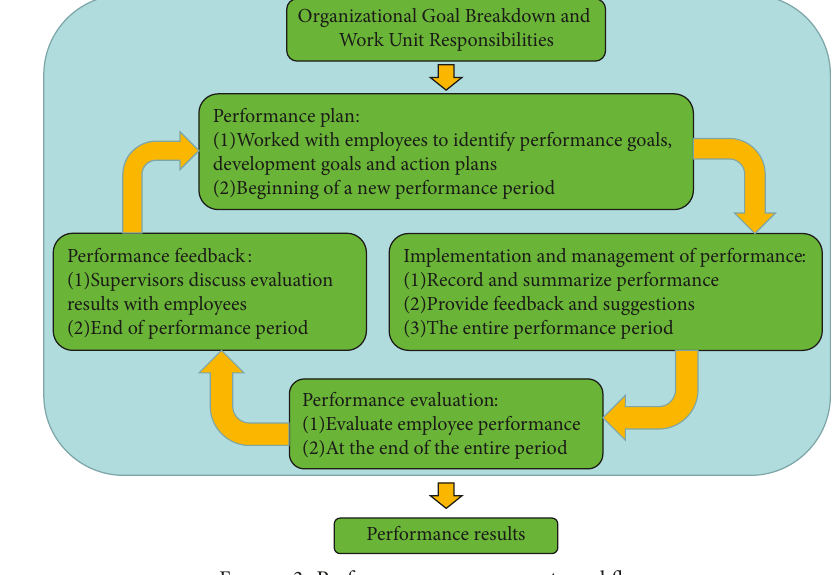
Figure 3: Performance management workflow.